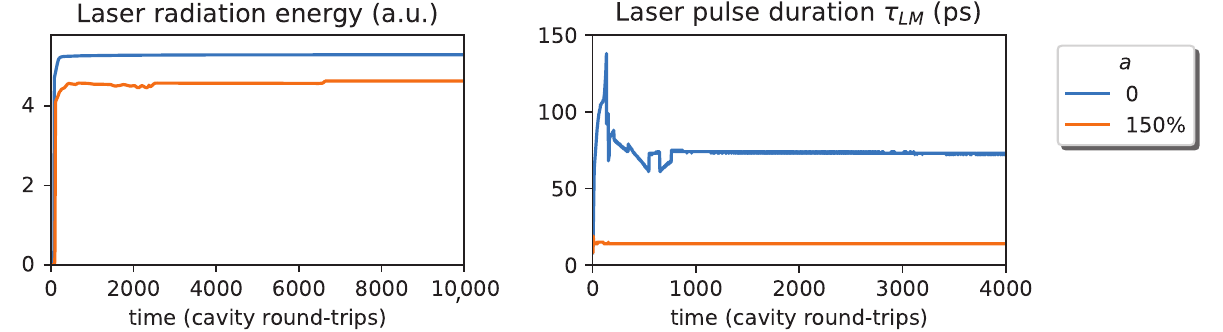
, Figure 8. The build-up of laser radiation energy ( left ) and laser pulse duration ( right ) at a = 0 and 150%. T d = 11,330 ps. Other simulation parameters are given in Table 3.